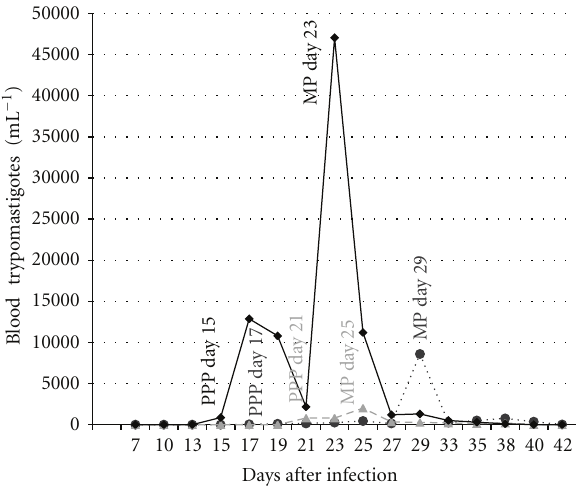
Figure 2: Parasitemia. Mean parasitemia at di ff erent days postin- fection, showing day of prepatent period (PPP), maximum peak of parasitemia (MP), showing a very erratic pattern alternating negative with positive parasitemia readings. All dogs showed par- asitemia but no di ff erences were found among groups ( P > 0 . 05). Same symbols as Figure